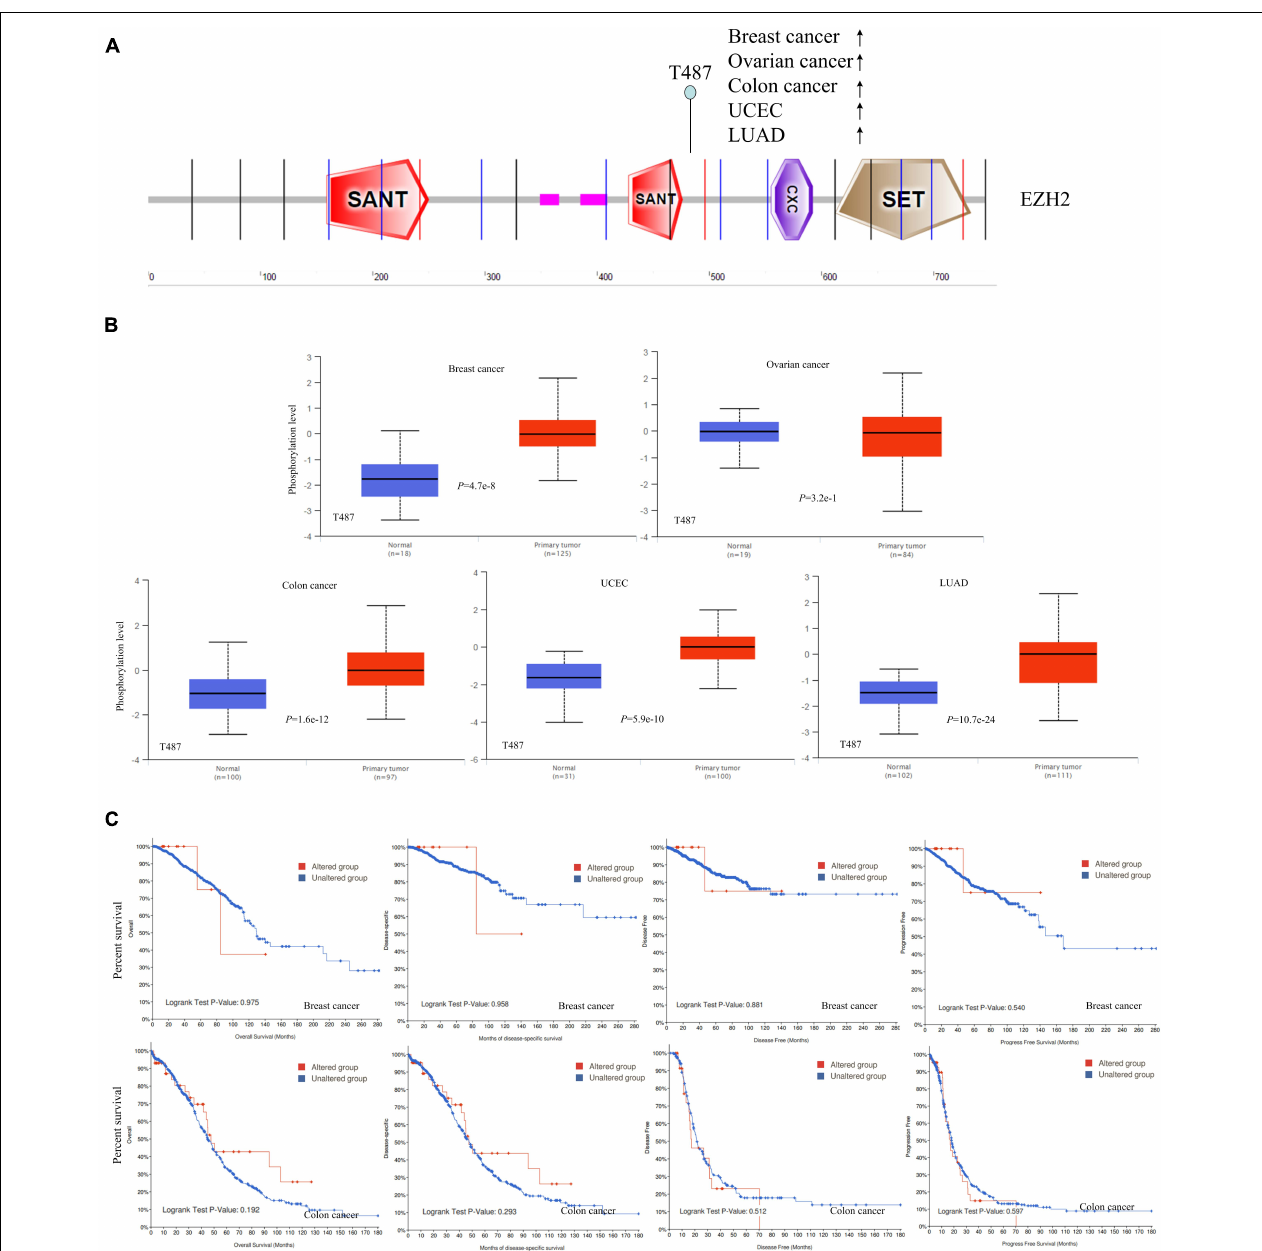
FIGURE 5 | Phosphorylation analysis of EZH2 protein in different tumors. (A) The phosphoprotein sites (T487) are displayed in the schematic diagram of the EZH2 protein. (B) The box plots for different cancers, including breast cancer, ovarian cancer, colon cancer, UCEC, and LUAD. (C) The potential association between phosphorylation level of EZH2 and the clinical survival prognosis of cases with breast cancer and colon cancer.